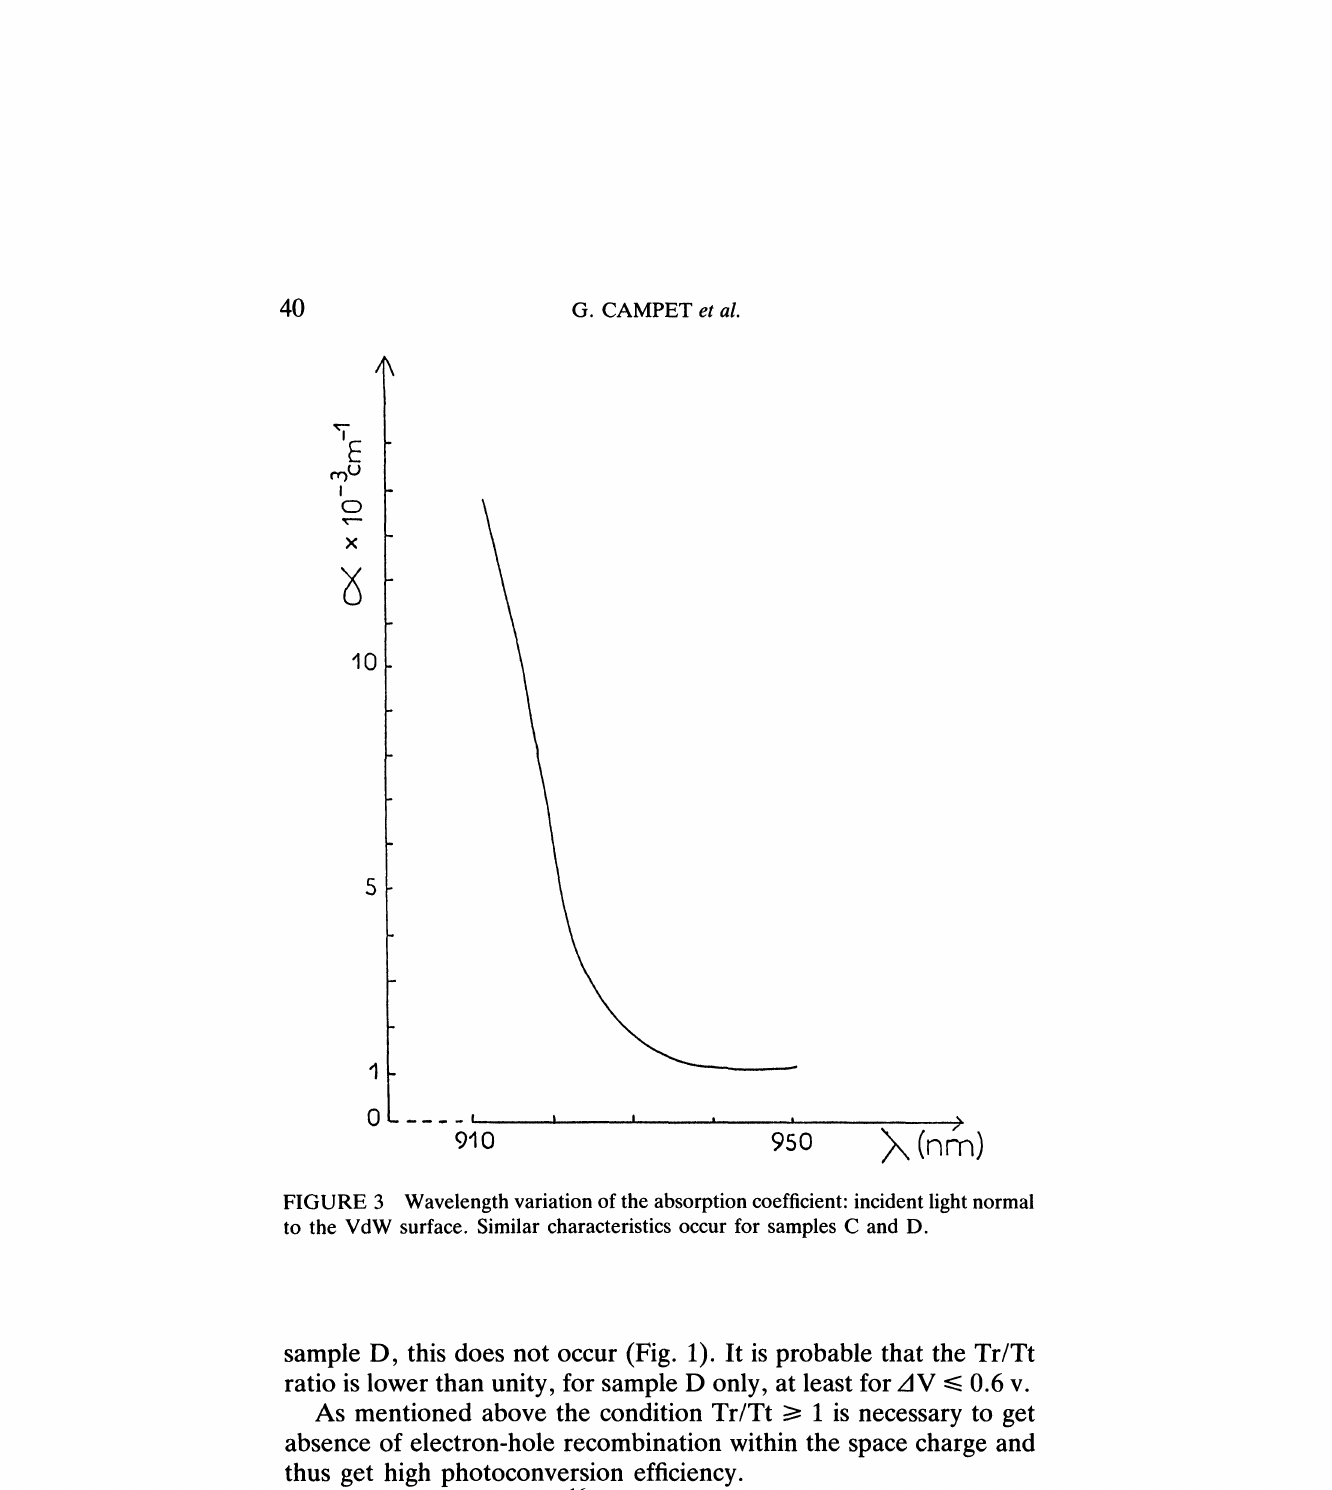
FIGURE 3 Wavelength variation of the absorption coefficient: incident light normal to the VdW surface. Similar characteristics occur for samples C and